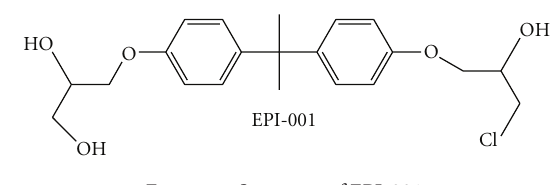
Figure 5: Structure of